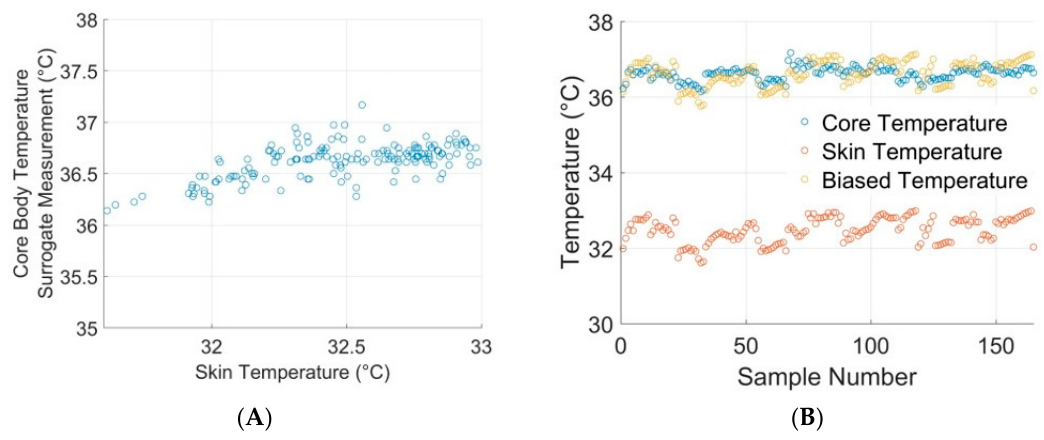
Figure 5. ( A ) Mean surrogate core body temperature is plotted against mean skin temperature from multiple subjects. ( B ) Raw skin temperature is biased, demonstrating good coincidence with surrogate core body temperature